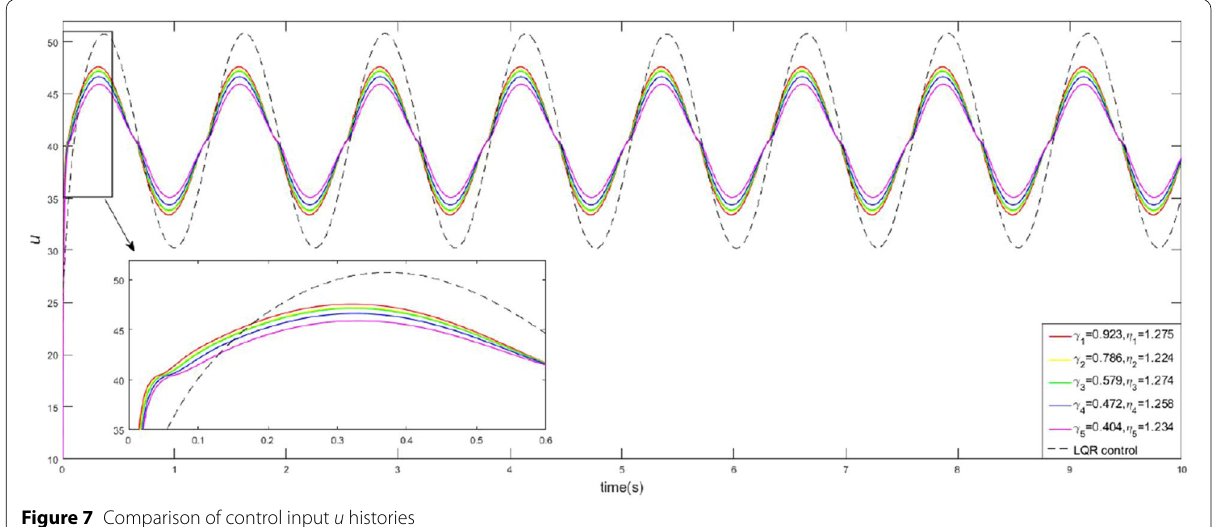
Figure 7 Comparison of control input u histories